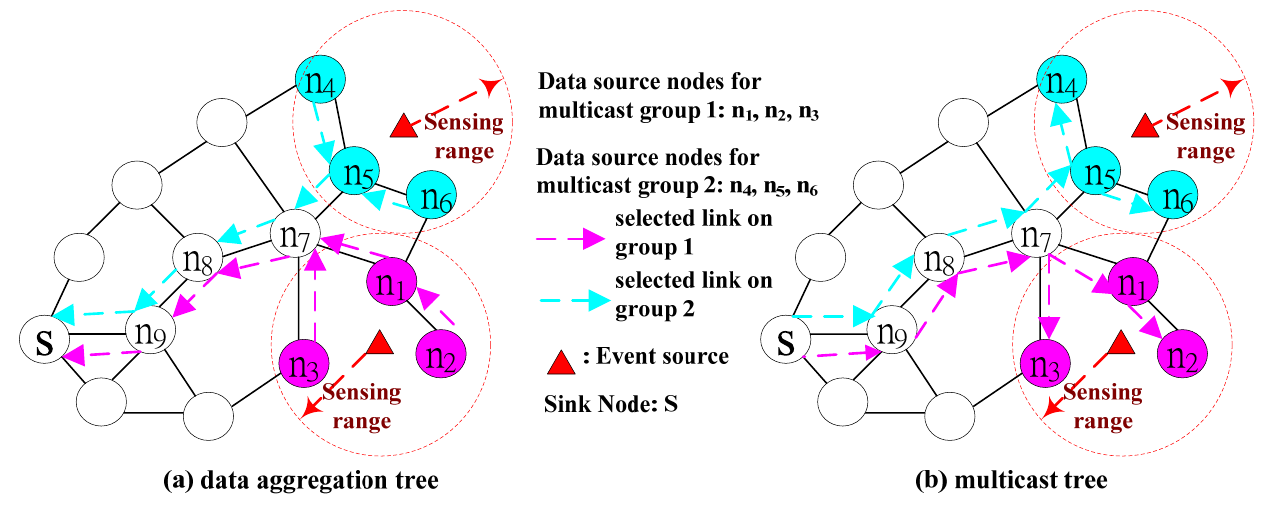
Figure 4. Data aggregation trees and the corresponding multicast trees in the